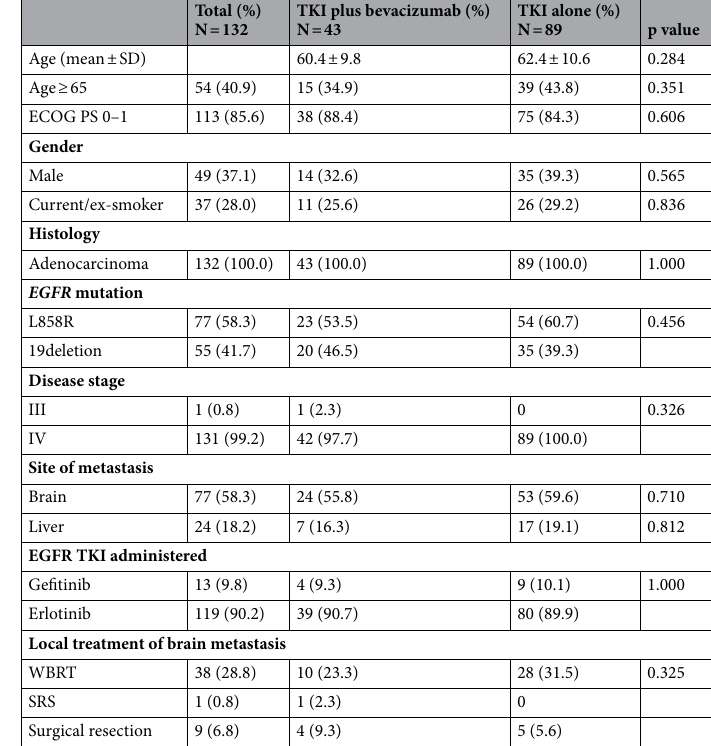
Table 3. Propensity-score matched cohort. WBRT whole brain radiotherapy, SRS stereotactic